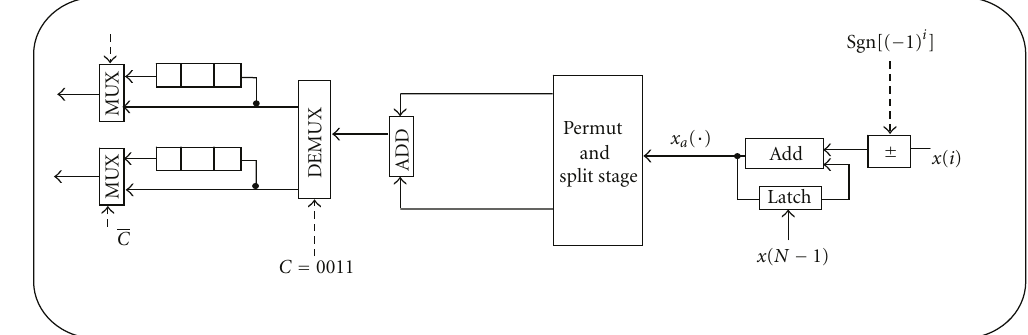
Figure 5: The structure of the preprocessing stage for DCT of length N = 7.